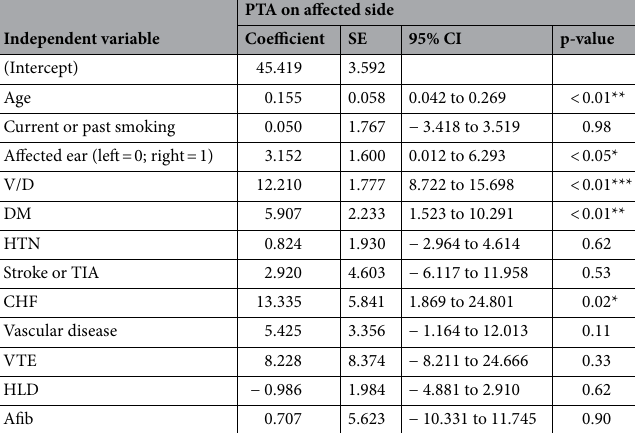
Table 3. Results of multivariate regression of atherosclerosis factors predicting severity of hearing loss (PTA) on affected side. Same abbreviations as in Table 1. Dependent variable = PTA on affected side. Multiple R 2